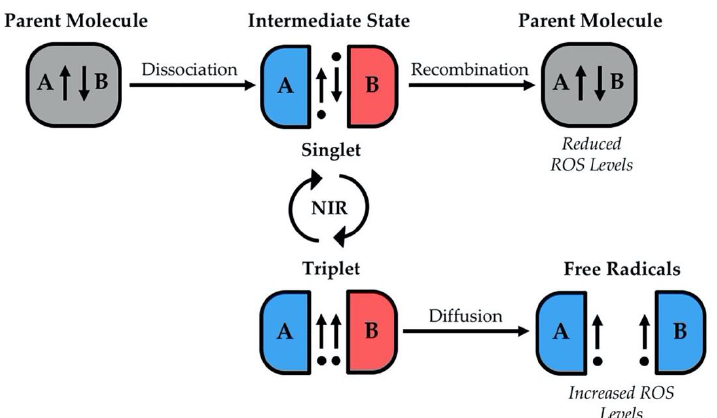
Figure 1. Theoretical model depicting field effects on electron spin state and radical pair recombination. Singlet state is an antiparallel spin and allows for recombination, yielding fewer reactive oxygen species (ROS). Triplet state is a parallel spin and allows for diffusion of radicals yielding more ROS. NIR: non-ionizing radiation.